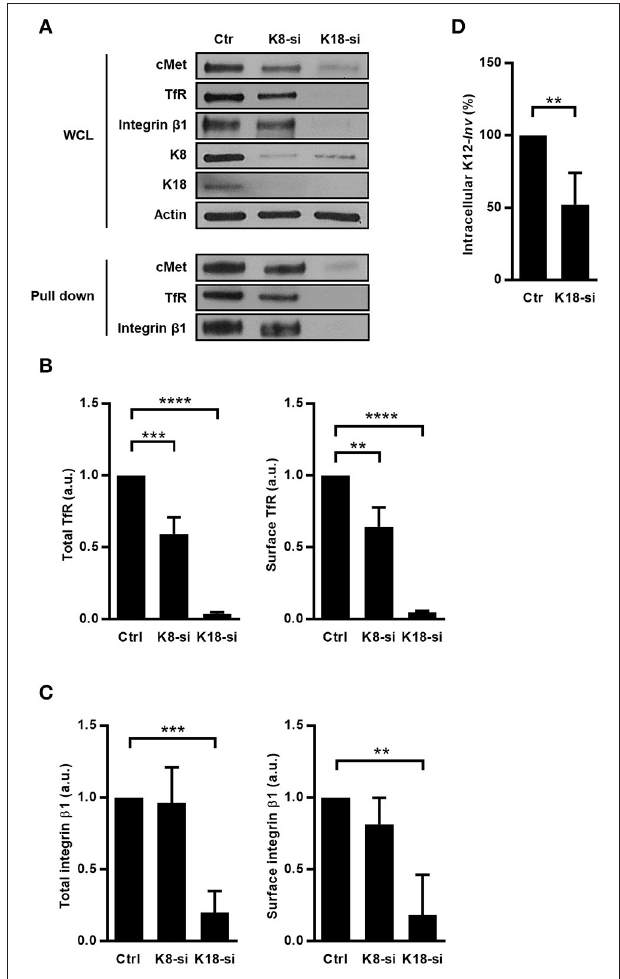
FIGURE 6 | K8 and K18 depletion perturbs expression and surface localization of transmembrane receptors. (A) Surface proteins of control (Ctr), K8- (K8-si), and K18-depleted (K18-si) HeLa cells were biotinylated, recovered from total cell extracts and pulled down using neutravidin beads. Biotinylated samples, which corresponds to surface exposed proteins, and whole cell lysates (WCL) were immunoblotted to detect cMet, TfR, and integrin β 1, together with Actin, K8, and K18. (B) Quantifications of TfR in WCL (left panel) and in biotinylated samples (right panel) from at least three independent experiments. (C) Quantifications of integrin β 1 in WCL (left panel) and in biotinylated samples (right panel) from at least three independent experiments (a.u., arbitrary units). (D) Functional impact of K18 in the expression of ITGB1 was assessed by gentamicin survival assay and CFU counting in K18-depleted HeLa cells (K18-si) incubated with invasive E. coli K12 expressing the Y. pseudotuberculosis invasin (K12-inv). Values of intracellular bacteria in Ctr cells were normalized to 100% and the entry levels in K18-si cells are expressed as relative values. Values are the mean ± S.E. of three independent experiments, each done in triplicate. Statistically significant differences are indicated: ** p < 0.01, *** p < 0.001, and **** p < 0.0001. Protein Synthesis and Stability Do Not Depend on K18 Expression The decrease of total levels of cMet, TfR, and integrin β 1 observed in K18-depleted cells lead us to put forward the possibility